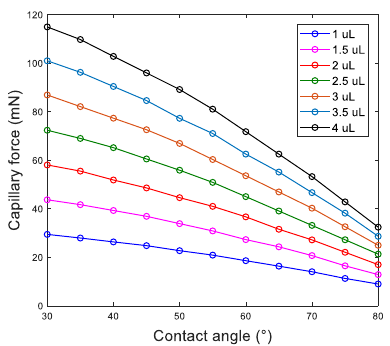
Figure 5. Force illustration of releasing a ribbon.